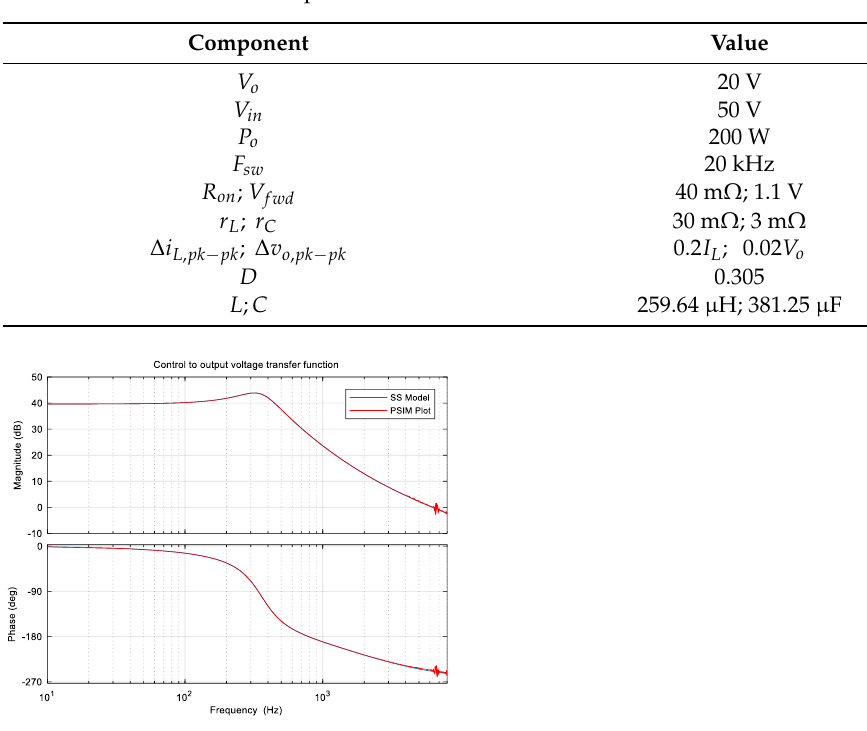
Figure 14. Control − to − output voltage transfer function for a buck − boost converter.